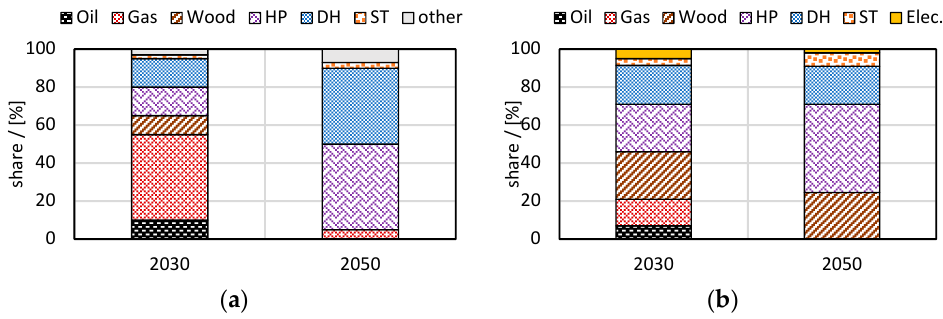
Figure 1. Share of District Heating (DH) in the heating of buildings acc. to ( a ) for Austria [2] and ( b ) for Germany [3]; prediction for 2030 and 2050 (i.e., HP: Heat Pump, ST: Solar Thermal, Elec. Elec- tricity).